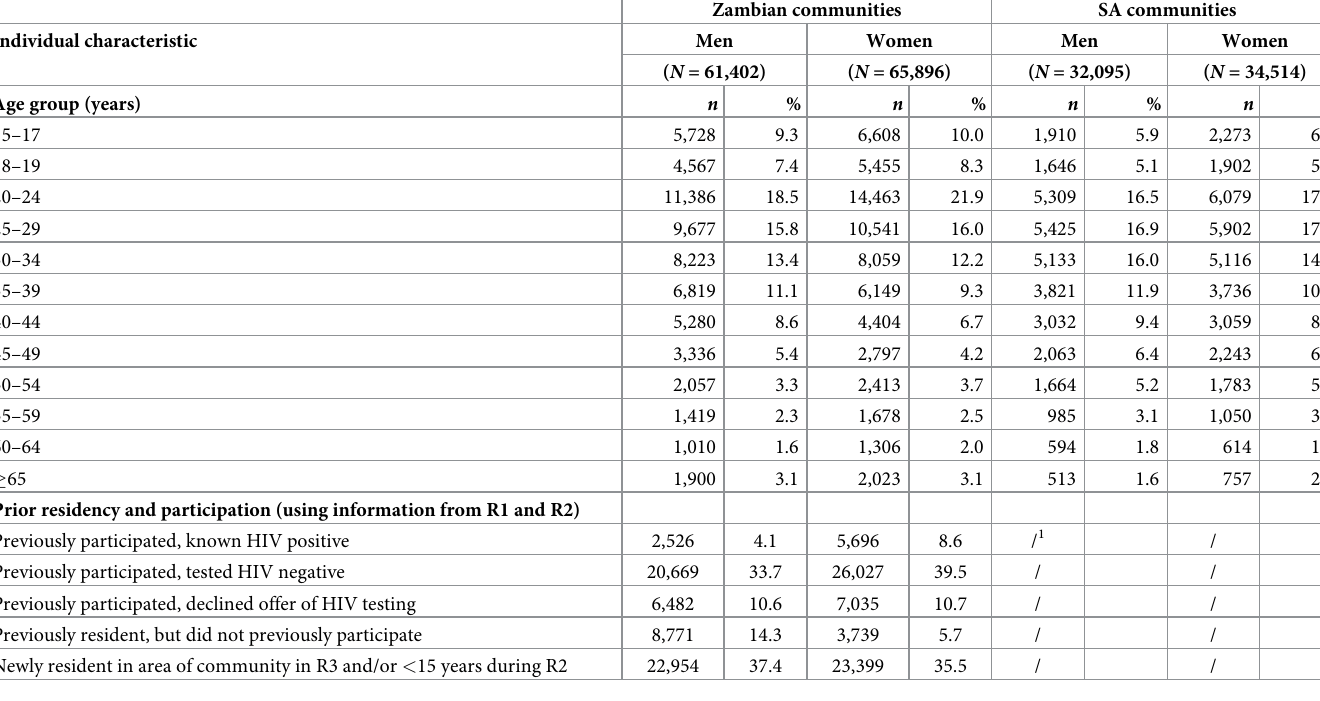
Table 1. Arm A: Population structure among individuals enumerated as a household member in